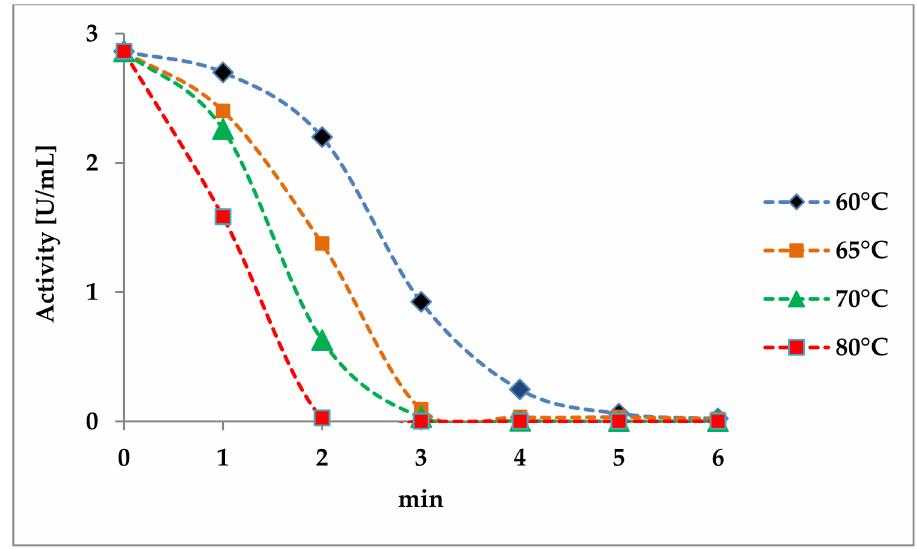
Figure 4. Influence of a heat treatment on must laccase